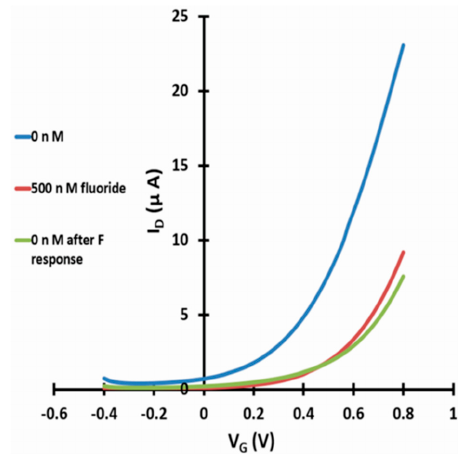
Figure 7. WGTFT fluoride response and recovery. Linear transfer characteristics for a WGTFT sensitised with La-loaded chelating resin under a test cycle of DI water (0 nm fluoride) ⇒ 500 nm fluoride ⇒ DI water (0 nm fluoride) again in the sample pool.